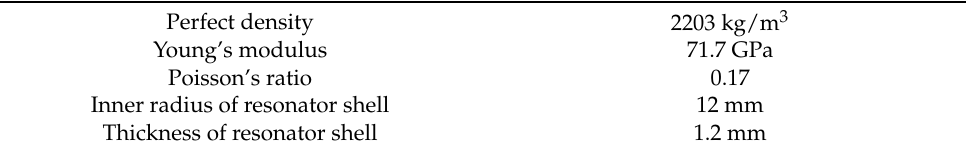
Table 1. Material and structure parameters of the resonator.